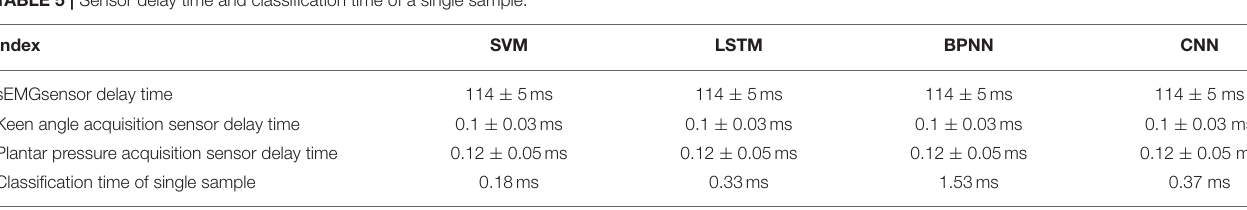
TABLE 5 | Sensor delay time and classification time of a single